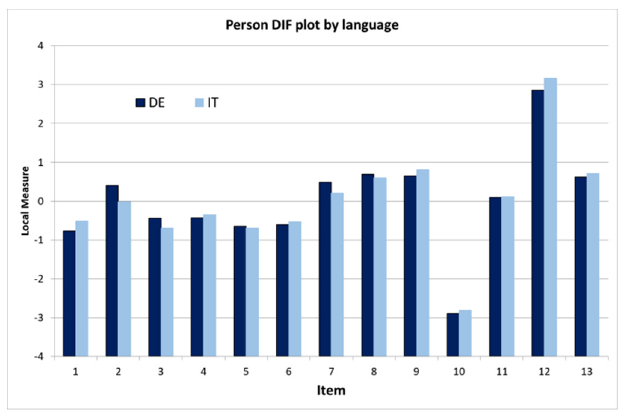
Figure 2. Person DIF plots according to gender, work experience, workplace, age range, and lan- guage . Notes: gender = F/M; age range = 20–29 years, 30–39 years, 40–49 years, 50+; workplace = working on a ward or in a service; work experience = ≤ 5 or >5 years; language =